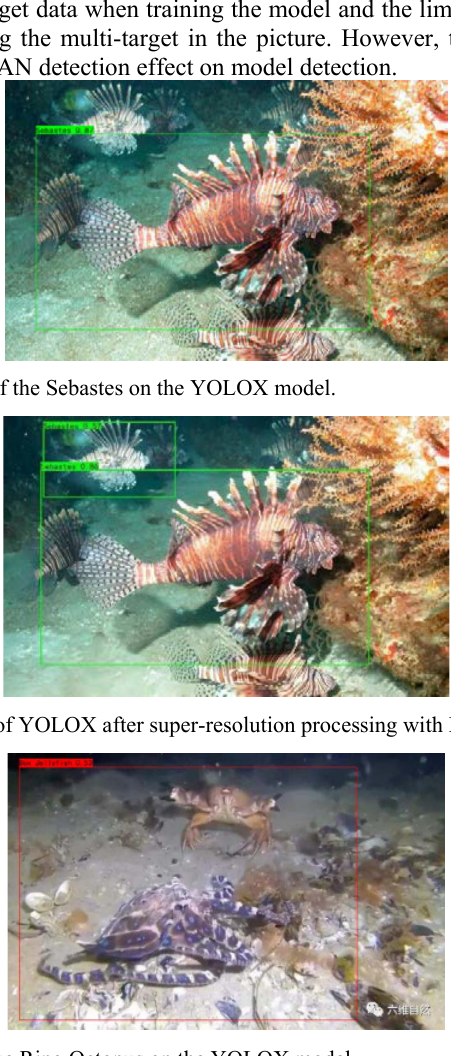
Fig. 11. Results of the Blue Ring Octopus on the YOLOX